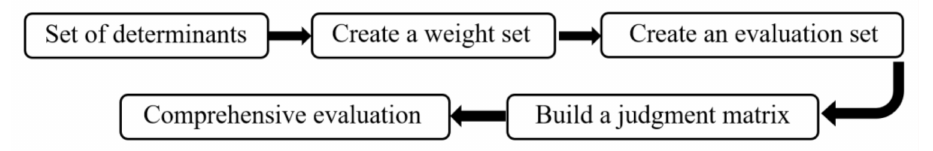
Figure 3. The basic methods and steps of FMT comprehensive